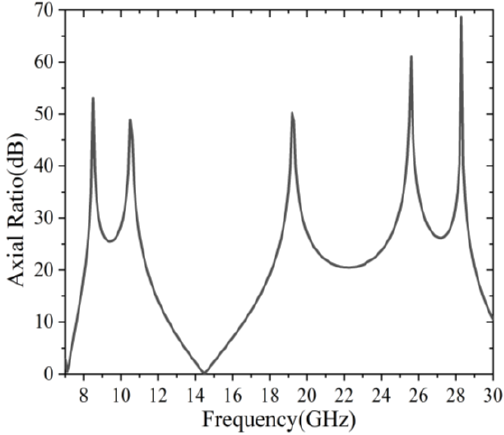
Figure 6. Simulated axial ratio for normal circular polarized incidence.